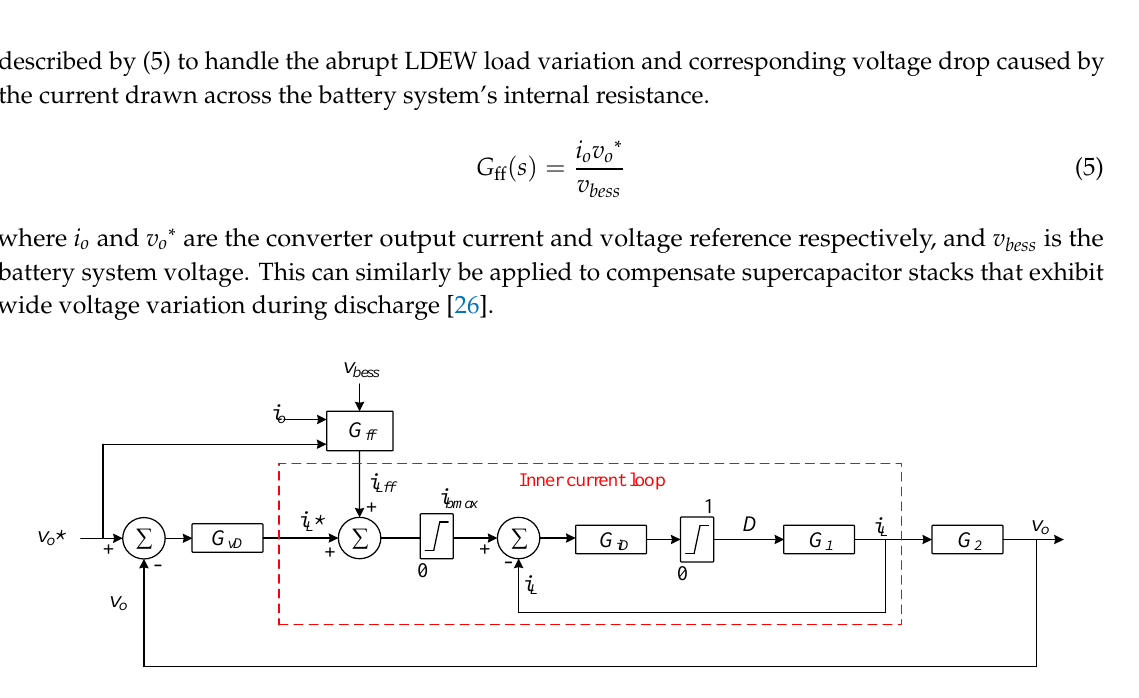
Table 4. DC / DC converter